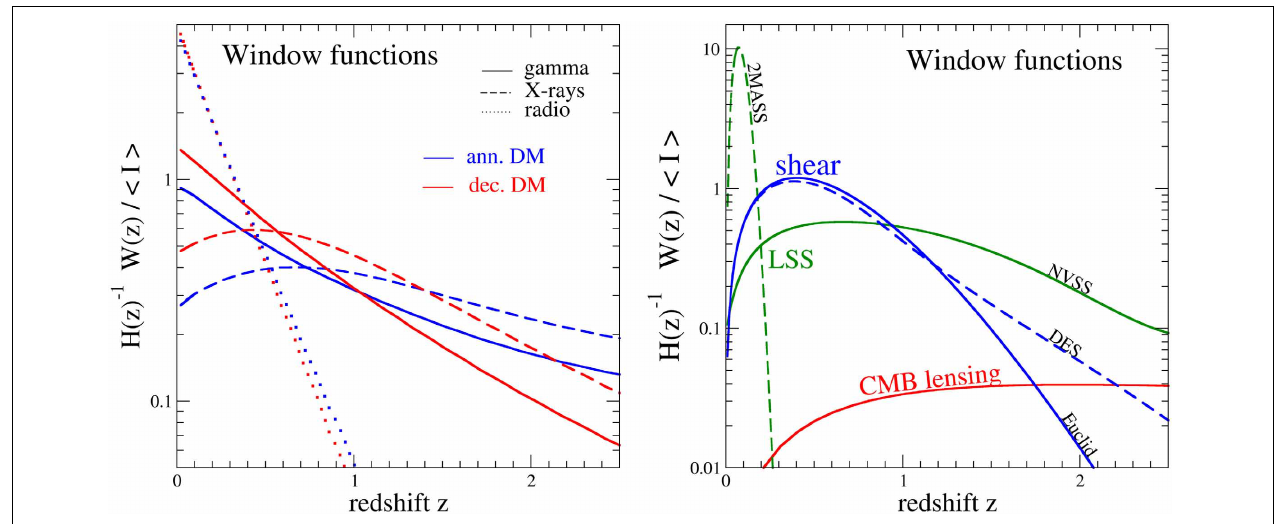
FIGURE 3 | Window functions. Left : Window functions as a function of the redshift for radio, X-ray, and gamma-ray emissions from annihilating/decaying DM. The window functions refer to reference frequencies/energies: ν = 1 GHz for radio, E = 10 keV for X-rays, E = 1 GeV for gamma-rays. They have